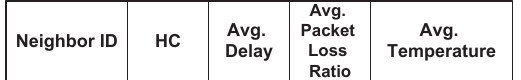
Figure 3. Neighbor Table